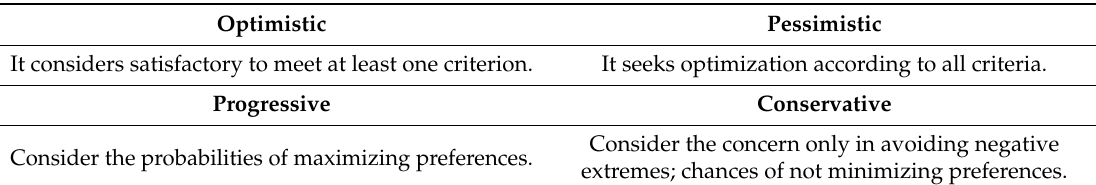
Table 11. Di ff erent approaches for combining probabilistic assessment. Optimistic Pessimistic